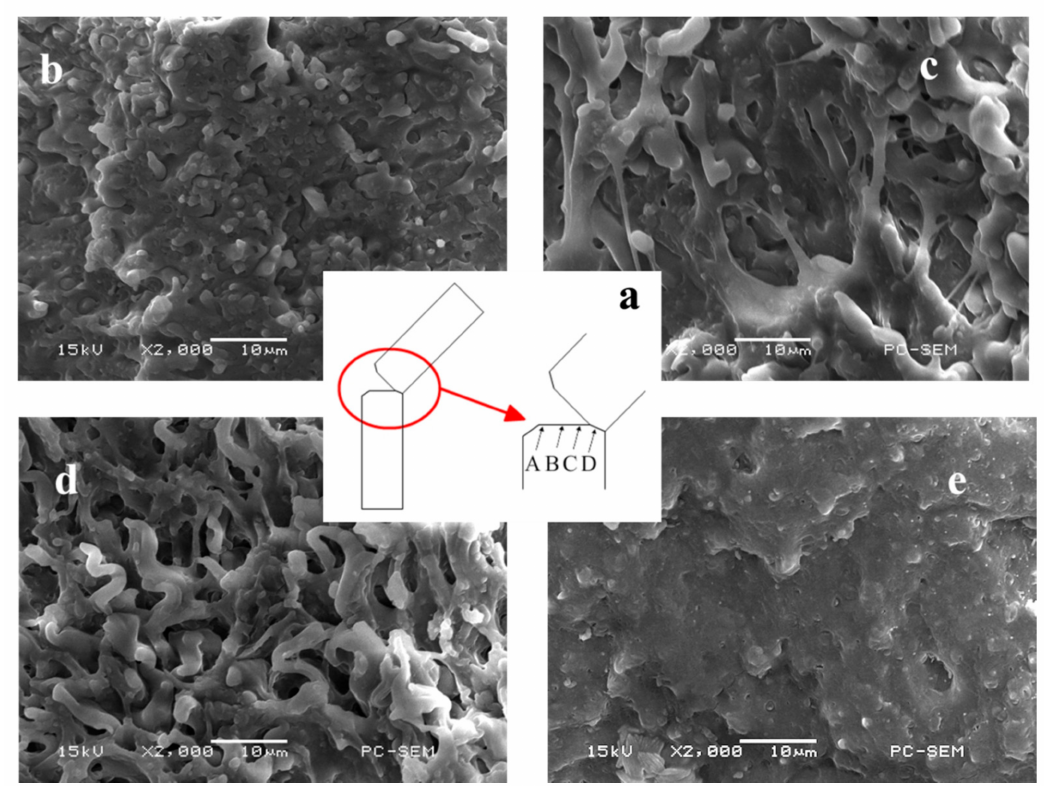
Figure 8. SEM micrographs of different regions on the impact fractured surface of the PPC/30%TPU sample. ( a ) Different regions of the impact fractured surface, ( b – e ) correspond to A–D in a,